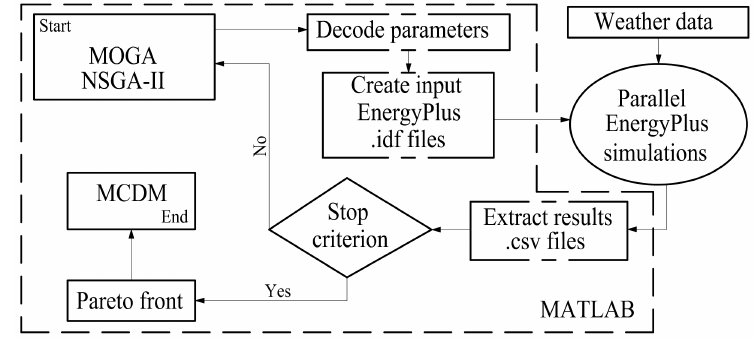
Figure 2. Flowchart diagram for the developed simulation/optimization